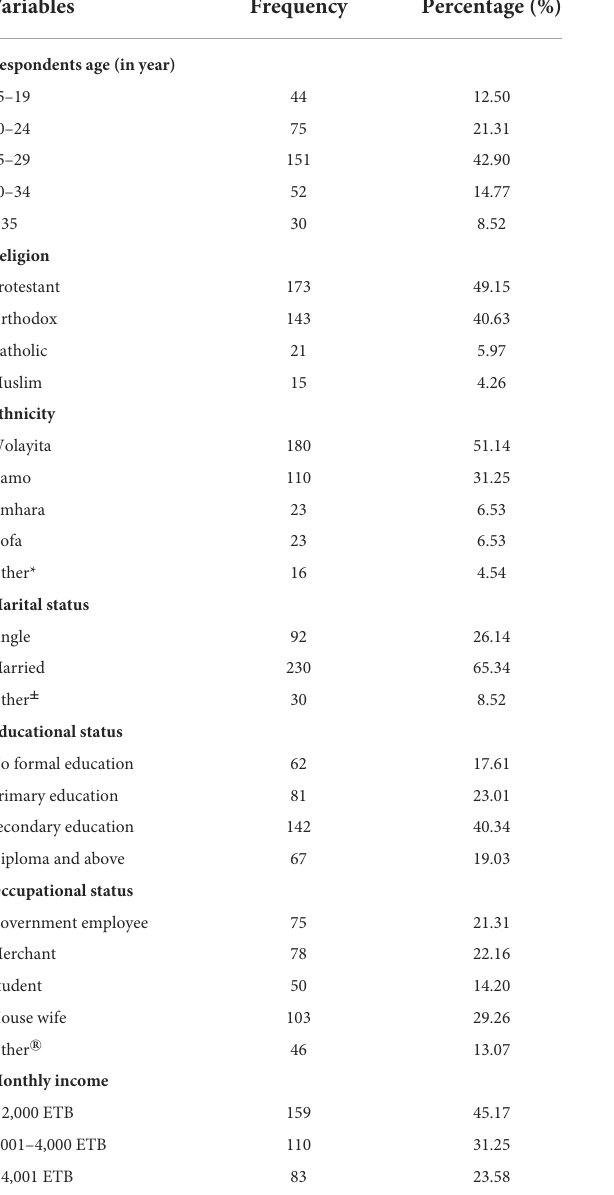
TABLE 2 Reproductive characteristics of women who received abortion care services in public hospitals of Arba Minch and Wolayita Sodo towns, southern Ethiopia,